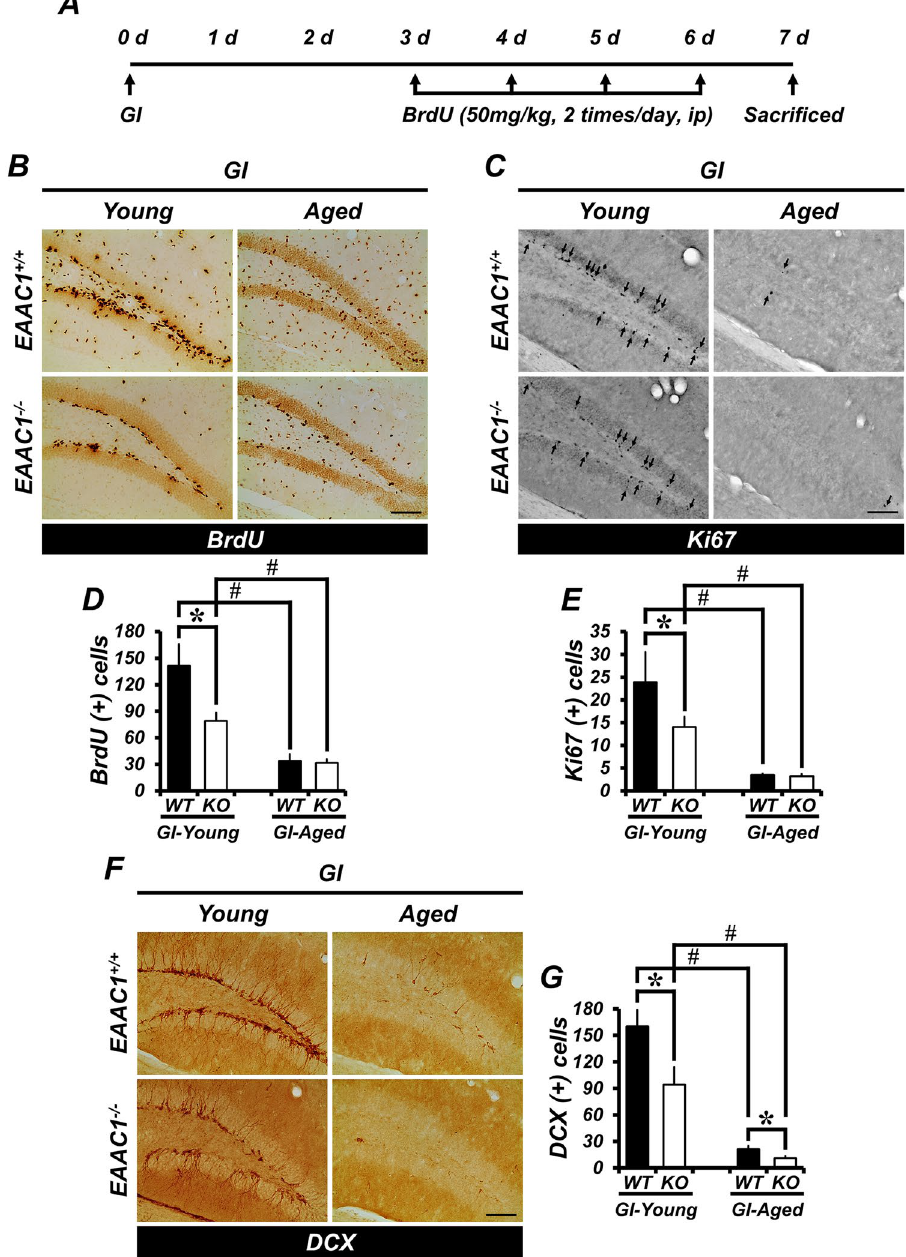
Figure 2. Ischemia-induced progenitor cell proliferation and neuroblast production are reduced in EAAC1 − / − mice. ( A ) The schematic diagram shows the experimental procedure used in this study. BrdU was intraperitoneally injected twice per day for 4 consecutive days from day 3 after ischemia. Mice were killed on day 7. ( B , C , F ) Representative images reveal BrdU- ( B ), Ki67- ( C ) and DCX-labeled cells ( F ) in the hippocampal dentate gyrus (DG) from young and aged mice (either WT or EAAC1 − / − ) at 7 days after ischemia. BrdU- and Ki67-labeled cells are located in the subgranular zone (SGZ) of the DG and appear most often in clusters. Detection of BrdU and Ki67 is accomplished with DAB. Ki67-expressing cells are indicated with an arrow. DCX-labeled cells are also located in the inner granular layer. Scale bar = 100 μ m. (D,E G) Bar graph shows the number of BrdU- ( D ), Ki67- ( E ) and DCX-labeled cells ( G ) in the SGZ from young and aged mice (WT or EAAC1 − / − ) at 7 days after ischemia. Data are expressed as the mean + SEM; n = 7–9 from each group, # p < 0.05 versus young